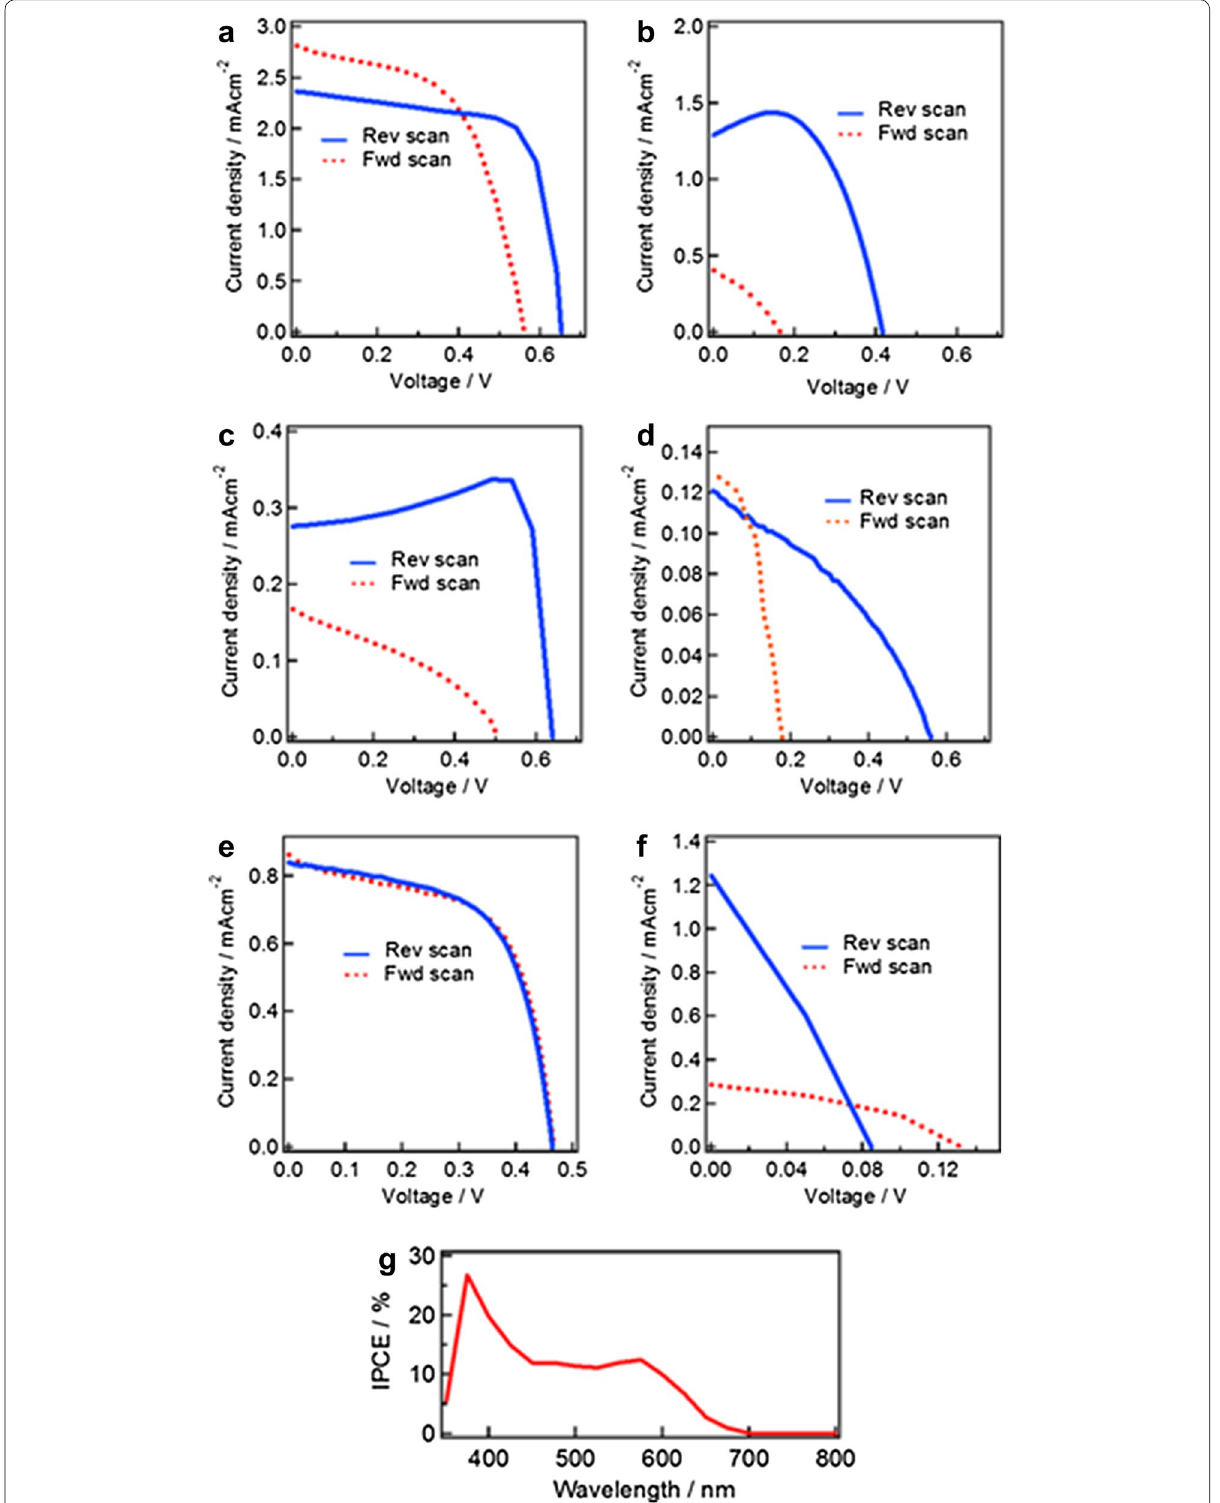
Fig. 8 Photo I–V curves of lead-free A 3 BX 6 -crystal solar cells measured under simulated irradiation (AM 1.5, 100 mW cm − 2 ) as normal mesoscopic and inverted architectures respectively. The photoabsorption layers are Ag 3 BiI 6 ( a , b ), Ag 3 BiI 3 (SCN) 3 ( c , d ), and Cu 3 BiI 6 ( e , f ) crystal films, and IPCE spectrum of the mesoscopic structure with the Ag 3 BiI 6 layer ( g ). The photovoltaic characteristics were summarized in Table